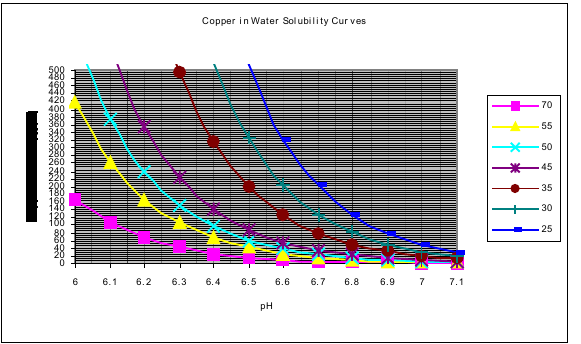
Figure 5: Copper solubility vs. pH.